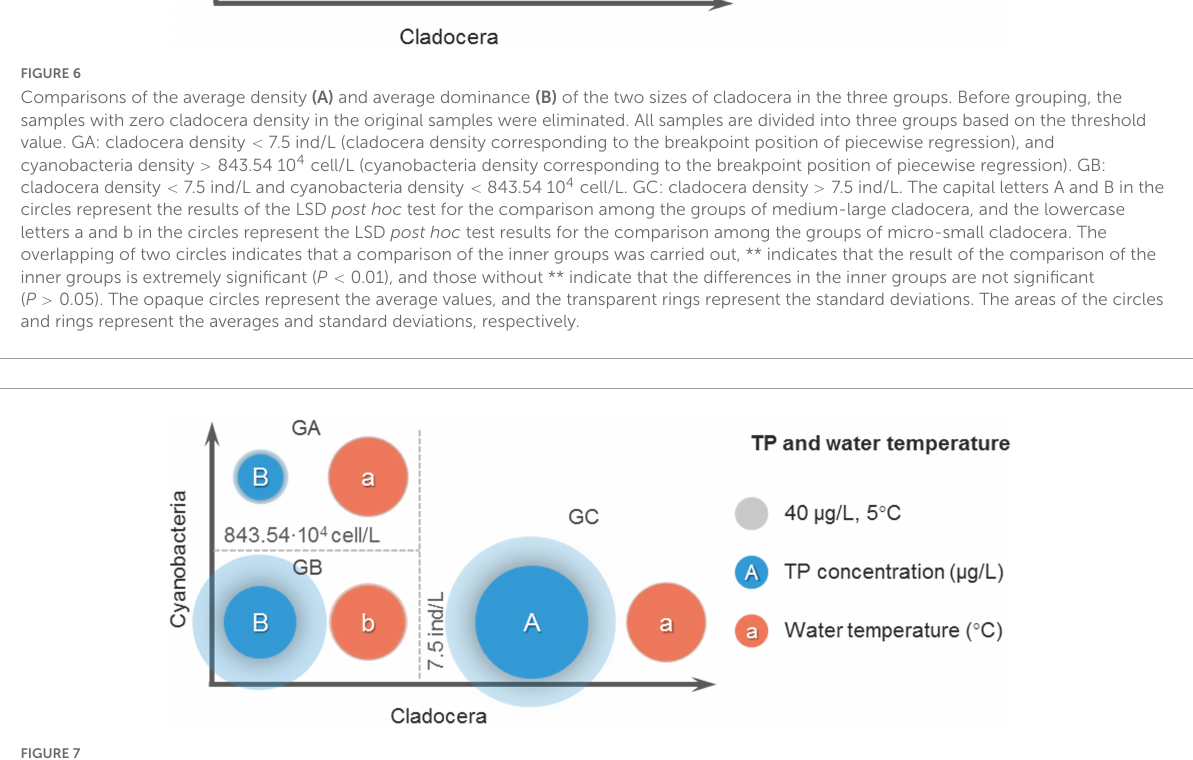
the density is close to or less than 7.5 ind/L, the fluctuation amplitude of the cyanobacteria density begins to increase rapidly. This shows that the control effect of cladocera on cyanobacteria is non-linear as the cladocera abundance changes.